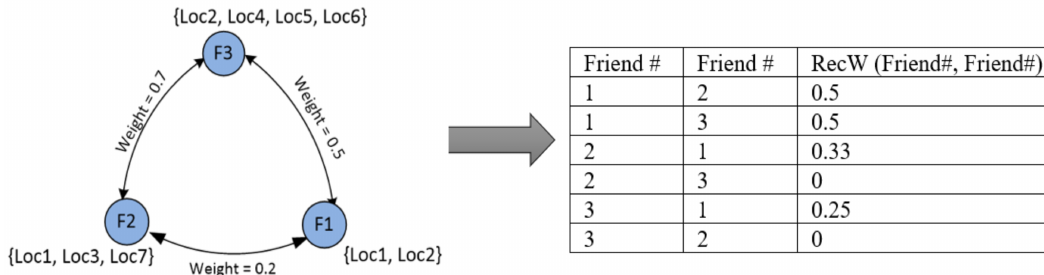
Figure 2. Example of a recommendation weight calculation. Table 1. Edge tust and edge influence among different friends in social